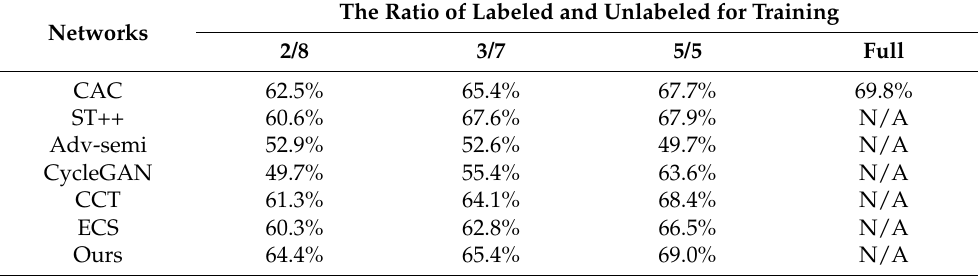
Table 1. Comparison with the baseline (SupOnly, i.e., using only supervised loss) and other state-of- the-art methods on Flame dataset with 2/8, 3/7, 5/5 and full labeled data. The Ratio of Labeled and Unlabeled for Training Networks 2/8 3/7 5/5 Full CAC 62.5% 65.4% 67.7% 69.8% ST++ 60.6% 67.6% 67.9% N/A Adv-semi 52.9% 52.6% 49.7% N/A CycleGAN 49.7% 55.4% 63.6% N/A CCT 61.3% 64.1% 68.4% N/A ECS 60.3% 62.8% 66.5% N/A Ours 64.4% 65.4% 69.0%